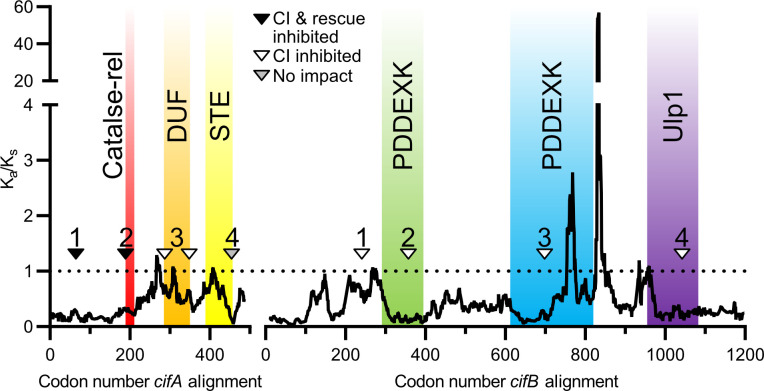
Sliding window analyses reveal selective pressures on regions surrounding evolution-guided mutagenesis.Analyses are based on pairwise alignments of cifA and cifB variants of wMel and wHa where the ratio of non-synonymous to synonymous substitutions (Ka/Ks) are calculated along a 25 amino acid sliding window. The analysis of CifA was previously reported [24]. The horizontal dotted line represents a Ka/Ks value of 1, indicating neutrality. Residues with Ka/Ks values above the dotted line are under positive selection and those under the line are under purifying selection. Both proteins are largely under strong purifying selection, but CifB has two regions of positive selection. Sites mutated in CifA1, CifA2, CifA4, CifB2, CifB3, and CifB4 are in regions of purifying selection. Sites mutated in CifA3 and CifB1 appear to be under neutrality or slight purifying selection. Triangles on protein schematics represent a selection of mutated amino acids. The specific amino acids mutated are further illustrated in Figs 2A and 3A for CifA and CifB respectively. Annotations are from prior studies and based on structural homology based analyses [27].